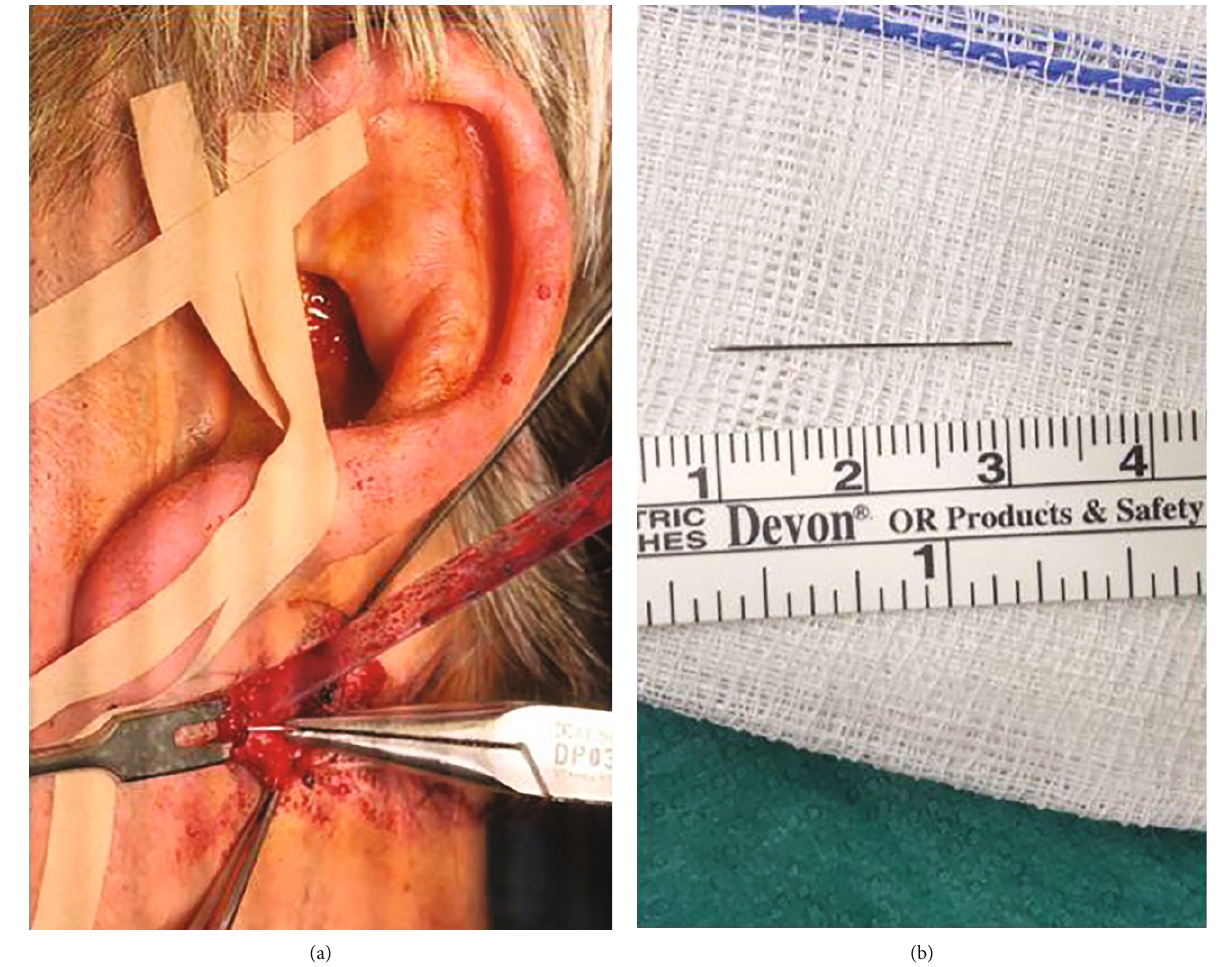
Figure 3: Intraoperative retrieval of the 2.1cm fractured hypodermic needle (a) and measurement afterwards